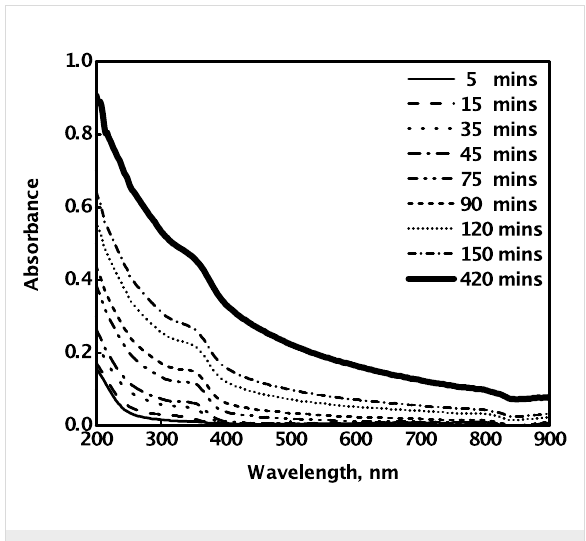
Figure 4: The effect of aging on the absorption spectrum of PVA- capped CdSe quantum dots synthesized by the reaction of 2 × 10 −